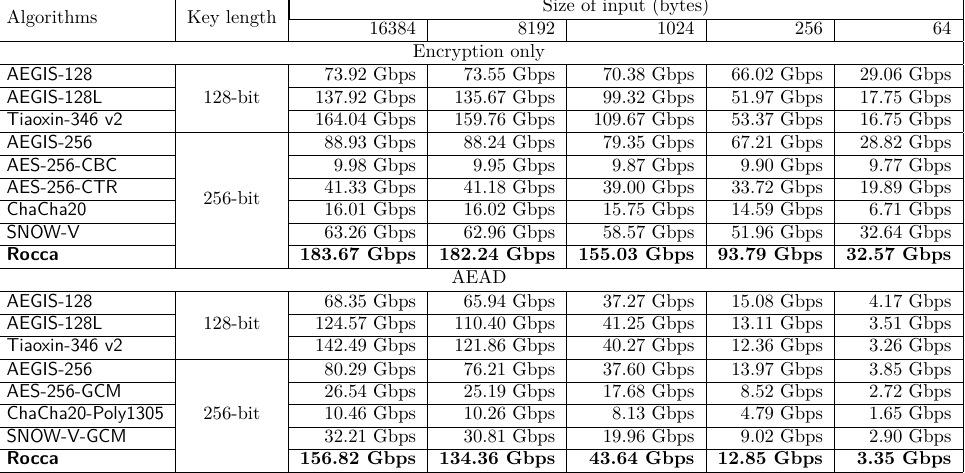
Table 8: Performance on Intel(R) Core(TM) i9-10910 CPU@3.60GHz with 64 GB